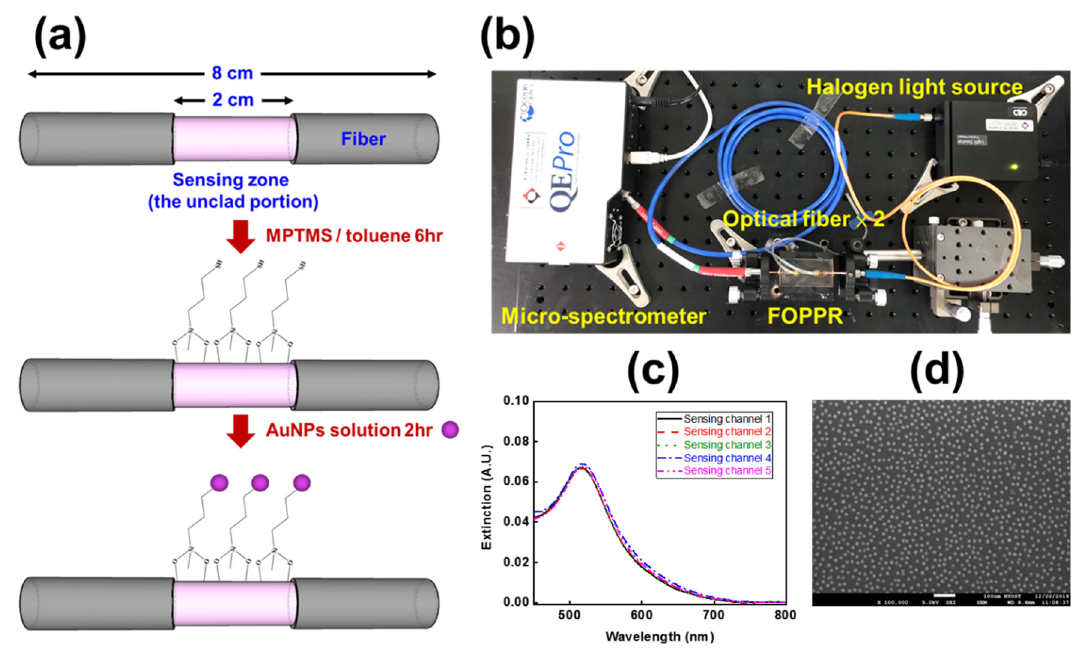
Figure 3. ( a ) Schematic of the seed-mediated growth method with AuNps on the unclad portion of optical fiber; ( b ) illustration of the fiber-optic spectrum system; ( c ) extinction spectra of the FOPPR sensors; ( d ) the SEM image of the gold nanoparticles (AuNPs) on the optical fiber.